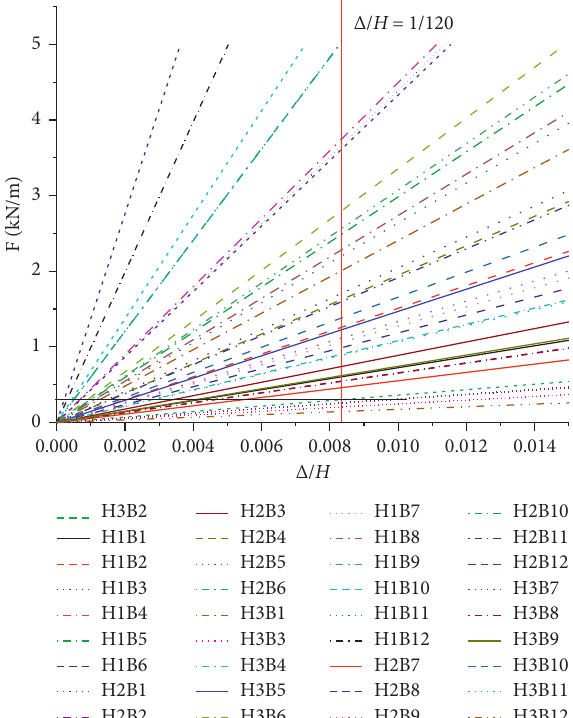
Figure 10: Correlation curve of F and Δ / H